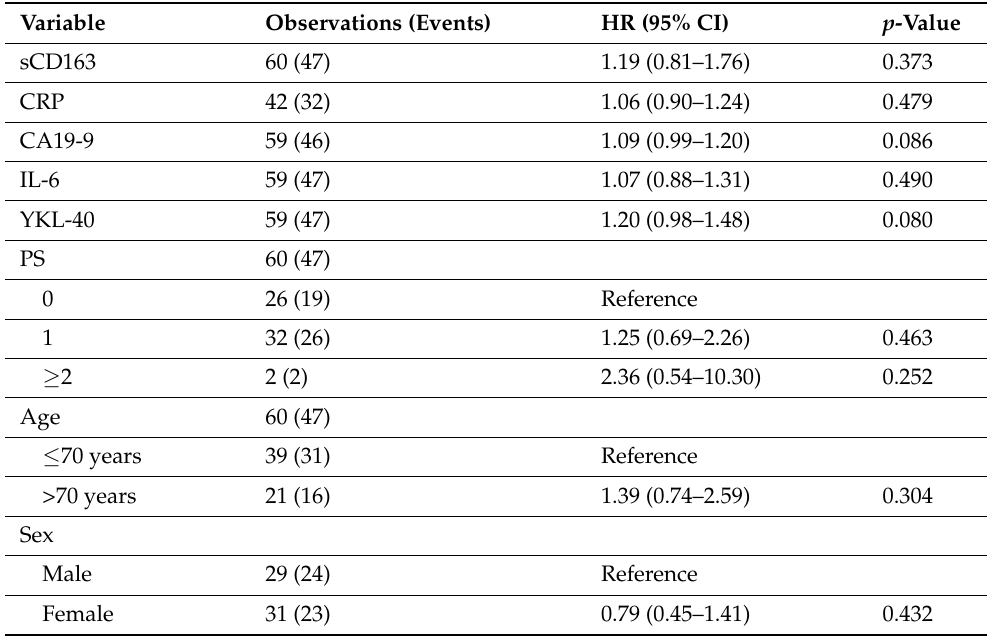
Table 3. Univariate Cox regression analyses for overall survival according to sCD163, CRP, CA19-9, IL-6 and YKL-40 concentrations (log-transformed), performance status, age, and sex, for patients with stage 1 + 2 pancreatic ductal adenocarcinoma.